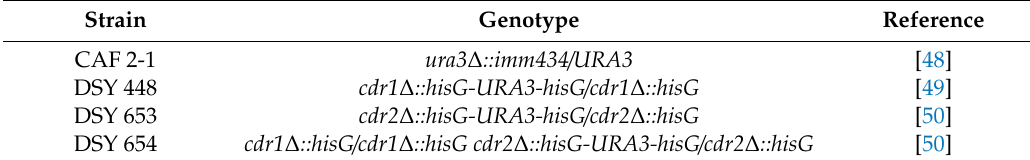
Table 3. Collection of C. albicans strains that was used in this study. Strain CAF 2-1 is treated as a marked delta in the Genotype